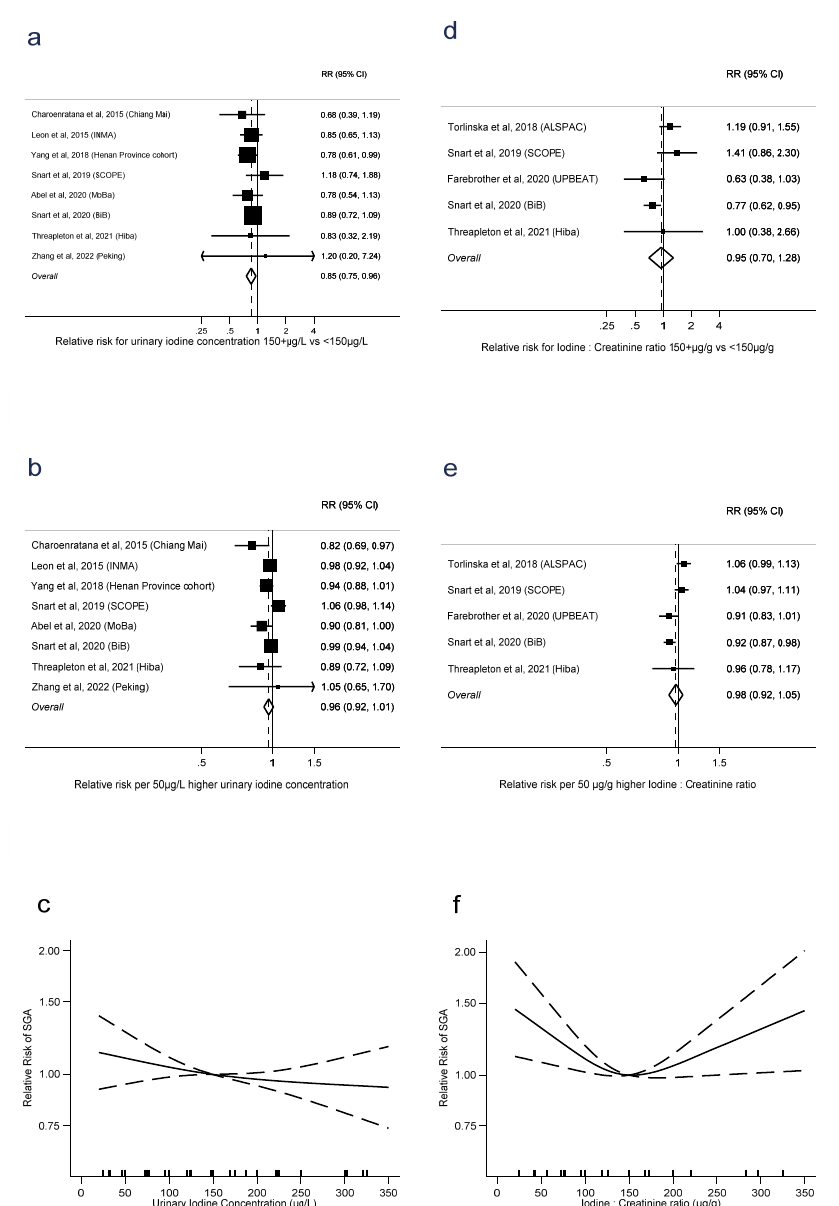
Figure 4. Urinary iodine concentration ( a – c ), iodine to creatinine ratio ( d – f ) and small for gestational age, dichotomous ( a , d ), linear ( b , e ) and nonlinear ( c , e ) meta-analyses. CI: Confidence interval; RR: Relative risk